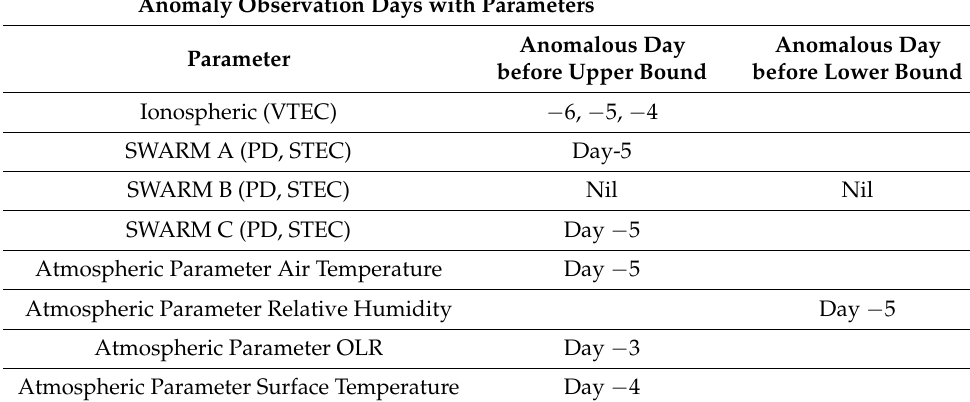
Table 3. Anomaly Observation with days of selected parameters. Anomaly Observation Days with Parameters